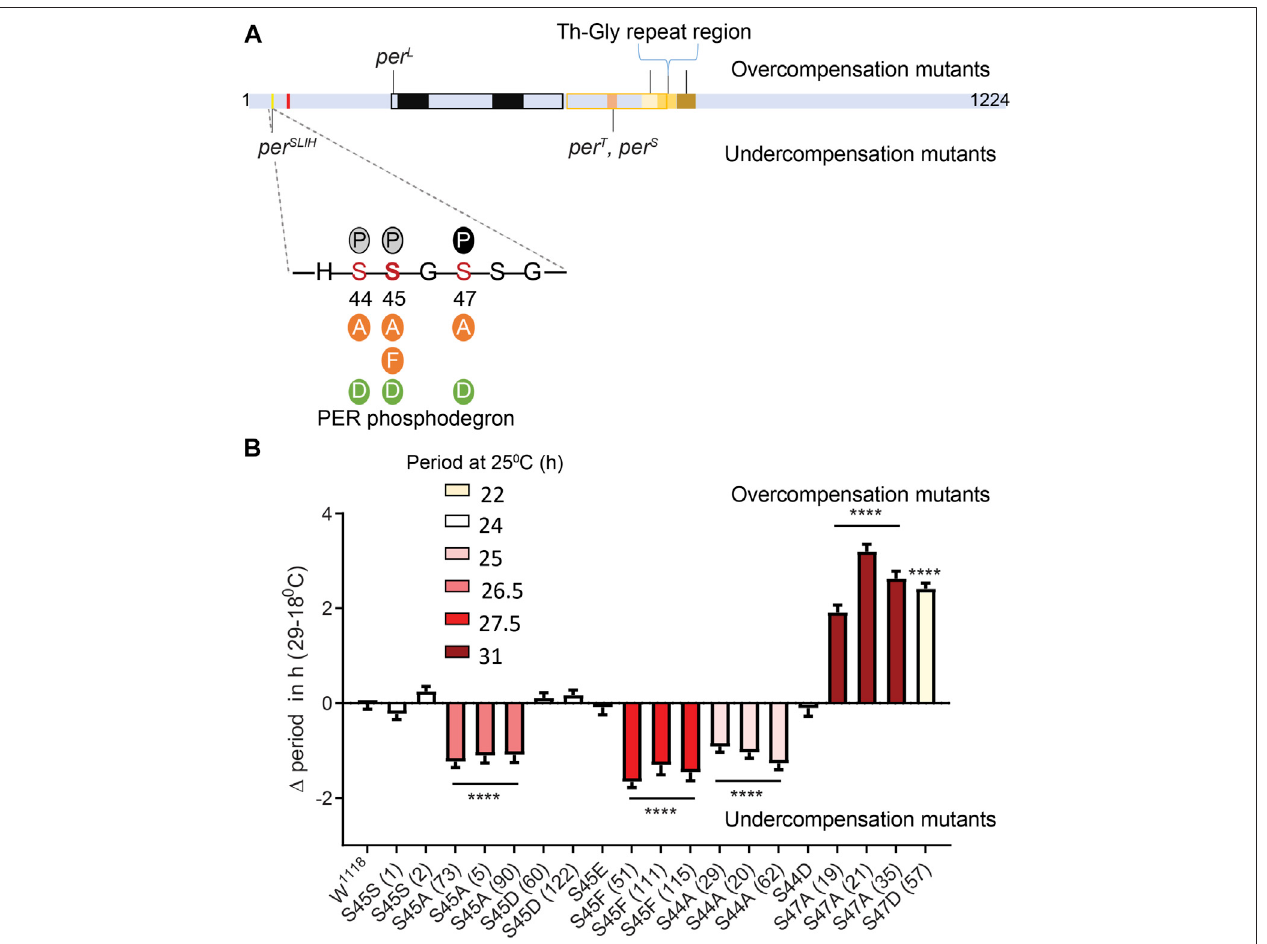
FIGURE1 | Differential modulation oftemperaturecompensation by three Serine residues inthe PER phosphodegron. (A) Schematic ofPER protein depicting the relative positions of amino acids modi fi ed in various mutants affecting temperature compensation in Drosophila . Mutants above the PER schematic are overcompensated while mutants depicted below are undercompensated mutants. The magni fi ed region of PER shows residues of the dPER phosphodegron and the various substitutions (Serine to Alanine, Phenylalanine, Aspartate or Glutamate) we generated using CRISPR/CAS9. Bold S at the 45th residue indicates the position of per SLIH mutation. Solid P within black circle, shows that S47 position undergoes phosphorylation. Grey circles indicate potential additional phosphorylation sites at S44 and S45 (Chiu et al., 2008). Red mark indicate a putative NLS close to the phosphodegron (Chang and Reppert, 2003). (B) Graphical representation of the difference inperiod valuesofvarious mutants ofdPER phosphodegronat29and 18 ° C,relative tocontrols. Δ Periodvaluesforeach genotype wereoffsetbytheaverage difference in period observed at 29 and 18 ° C in S45SI and S45SII control lines, so that overcompensation or undercompensation compared to control is clearly represented. The color scheme denotes period of each mutant line at 25 ° C. Interestingly, S44A, S45A, and S47A all produce long period phenotype at 25 ° C. However, the directionality of their temperature compensation phenotypes is opposite between S44A/S45A and S47A. S44A, and S45A produce signi fi cant undercompensation while S47A and S47D shows overcompensation. Statistical signi fi cance was calculated using two-way ANOVA with Sidak ’ s multiple comparison test.